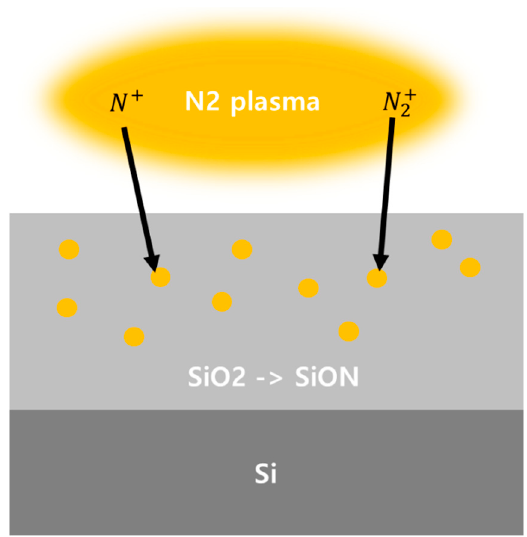
Figure 2. Schematic of the mechanism of creating SiON film.